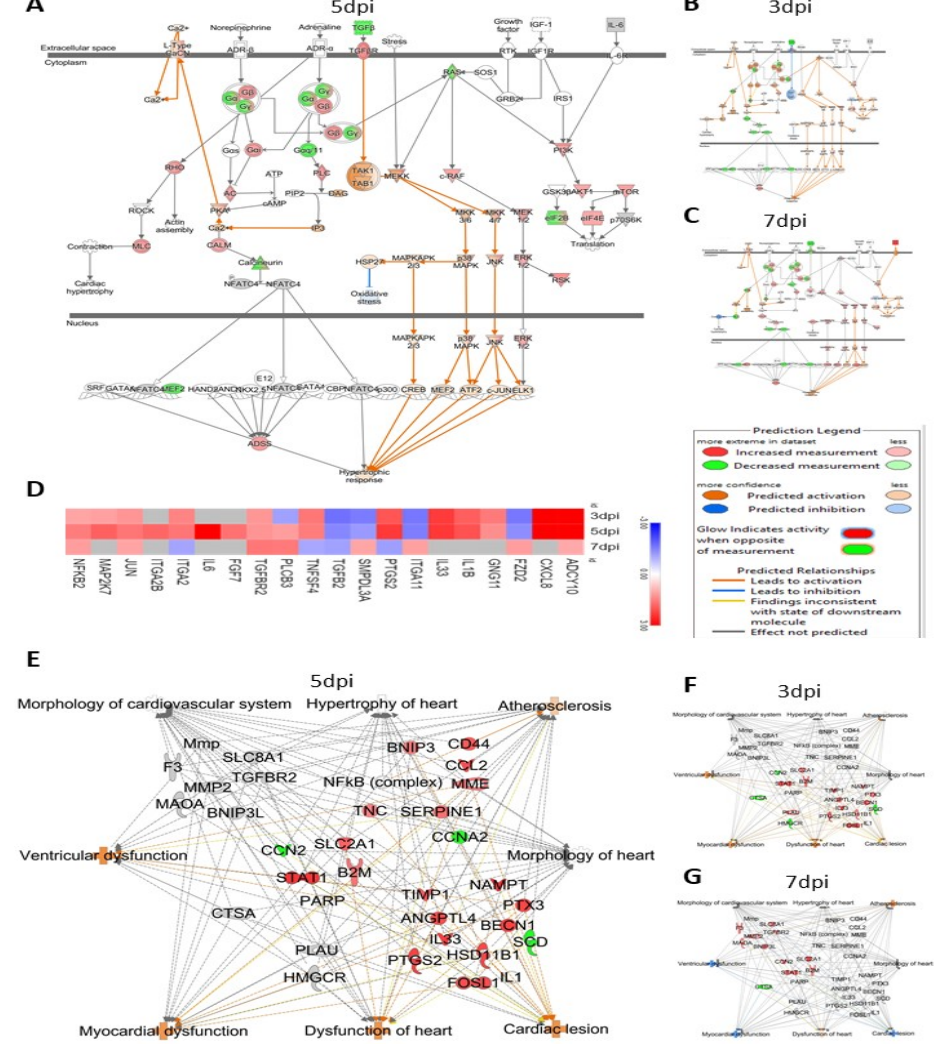
Figure 8. ZIKV infection significantly affects the levels of proteins involved in the cardiac hypertrophy pathway. IPA predicted activation of the cardiac hypertrophy pathway by Zika virus infection by ( A ) 3 dpi, ( B ) 7 dpi and ( C ) 5 dpi. ( D ). Heatmap of the proteins involved in cardiac hypertrophy pathway altered by ZIKV infection in HSerC. In the heatmap, red and blue represent up ‐ regulation and down ‐ regulation, respectively. Gray indicates the proteins were not detected at the respective time point. HSerC proteins associated with pathways that increase cardiovascular disease, that are affected by ZIKV infection at ( E ) 5 dpi ( F ) 3 dpi and ( G ) 7 dpi. Red and green represent up ‐ regulation and down ‐ regulation of protein expression, respectively. Abbreviations. dpi = Days post infection. Five proteins (CLIC1, SPARC, STAT1, STAT3 and PSMA2) were selected for valida ‐ tion based on their expression fold ‐ change and availability of commercial antibodies. Western blot was done (Figure 9A), and the intensities of protein bands were measured to determine the fold difference between the infected and mock conditions. The fold change of each protein measured by Western blot at three different time points was com ‐ pared side ‐ by ‐ side to the expression values determined by mass spectrometry (Figure 9B). All five proteins followed the same trend of expression by Western blot as measured by TMT ‐ mass spectrometry.